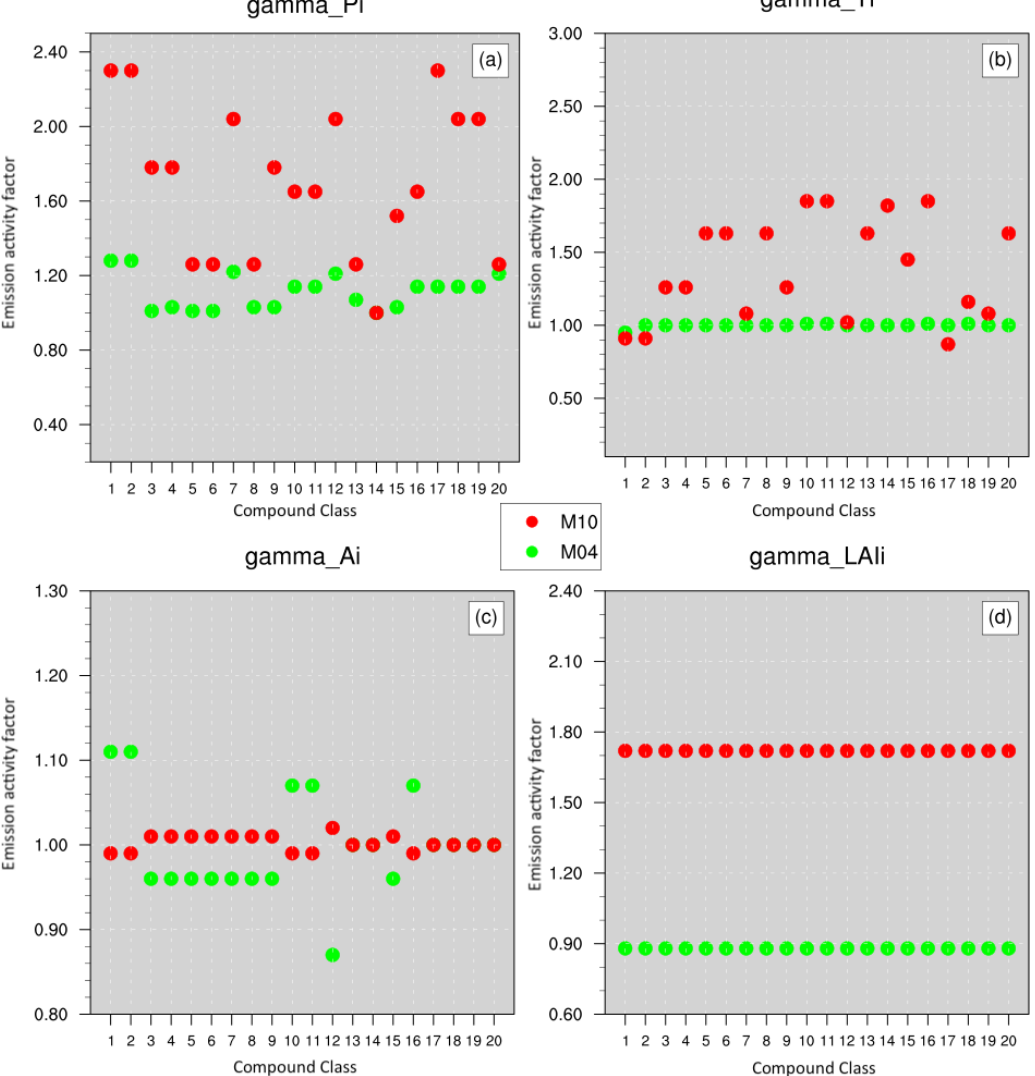
Figure 14. Emission activity factors ( y axis, dimensionless) from M2.04 (M04) and M2.10 (M10) for different compound classes (1: isoprene, 2: myrcene, 3: sabinene, 4: limonene, 5: 3-carene, 6: t- β -ocimene, 7: β -pinene, 8: α -pinene, 9: other monoterpenes, 10: α -farnesene, 11: β - caryophyllene, 12: other sesquiterpenes, 13: 232-MBO, 14: methanol, 15: acetone, 16: carbon monoxide, 17: nitric oxide, 18: bidirectional VOC, 19: stress VOC, 20: other VOC). Each panel is for a different meteorological factor: (a) photosynthetic photon flux density ( γ P , GAMMA_P), (b) temperature ( γ T , GAMMA_T), (c) leaf age ( γ age , GAMMA_A), and (d) leaf area index ( γ LAI , GAMMA_LAI). The factors refer to the city of Genoa (Italy) on 13 August (12:00UTC)